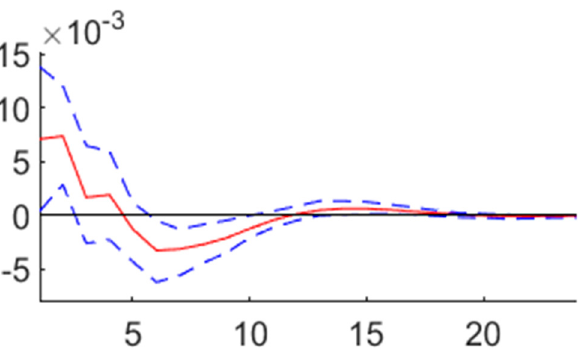
Figure 1. Impulse response function for the baseline specification. Note: the area between the dotted lines represents the 90% confidence interval.